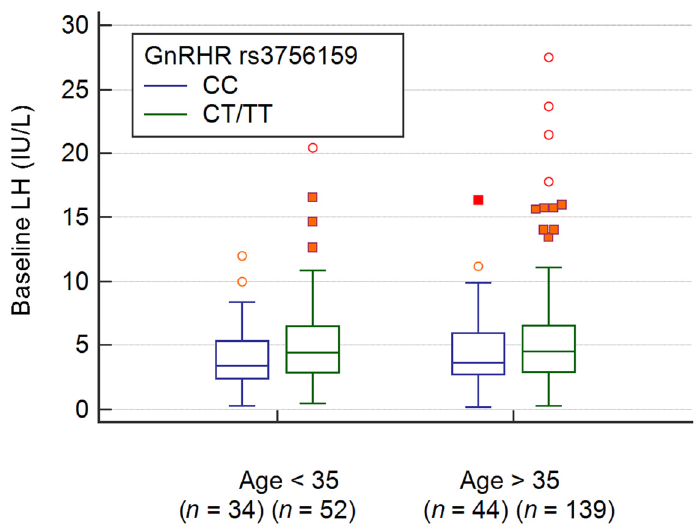
Figure 5. The baseline LH levels for patients with various GnRHR rs3756159 genotypes. There was no significant difference of these LH levels between CC vs. CT/TT genotypes in young (POSEIDON group 3, p = 0.095) or advanced age (POSEIDON group 4, p = 0.152) patients by Mann–Whitney U test.